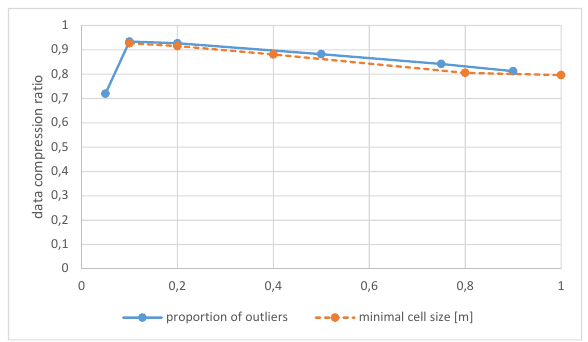
Figure 10. Resulting data compression ratio for different values of minimal cell size and the proportion of outliers.